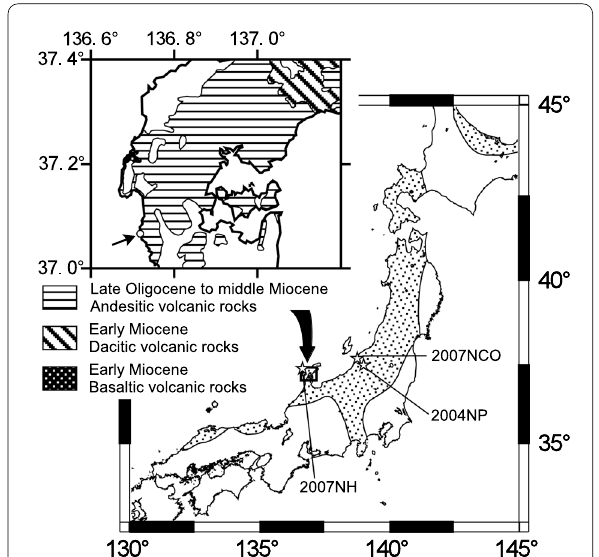
Fig. 1 Map of the Japanese island arc showing the distribution of the “Green Tuff” formation (dotted area), after Huzioka (1963). The stars represent the epicenters of the 2004 M6.6 mid‑Niigata Prefecture earthquake (2004NP), the 2007 M6.6 Niigataken Chuetsu‑oki earthquake (2007NCO), and the 2007 M6.7 Noto Hanto earthquake (2007NH). The upper left inset shows the volcaniclastic rocks distribution of the “Green Tuff” formation in the Noto Peninsula (Kaseno 1965). The Andesitic rock indicated by the gray areas represents the Anamizu Formation, where the tuff breccia samples for the present experiments were collected. The open circle shows the location drilled for sampling. The position of the inset is given by the rectangle box in the main figure